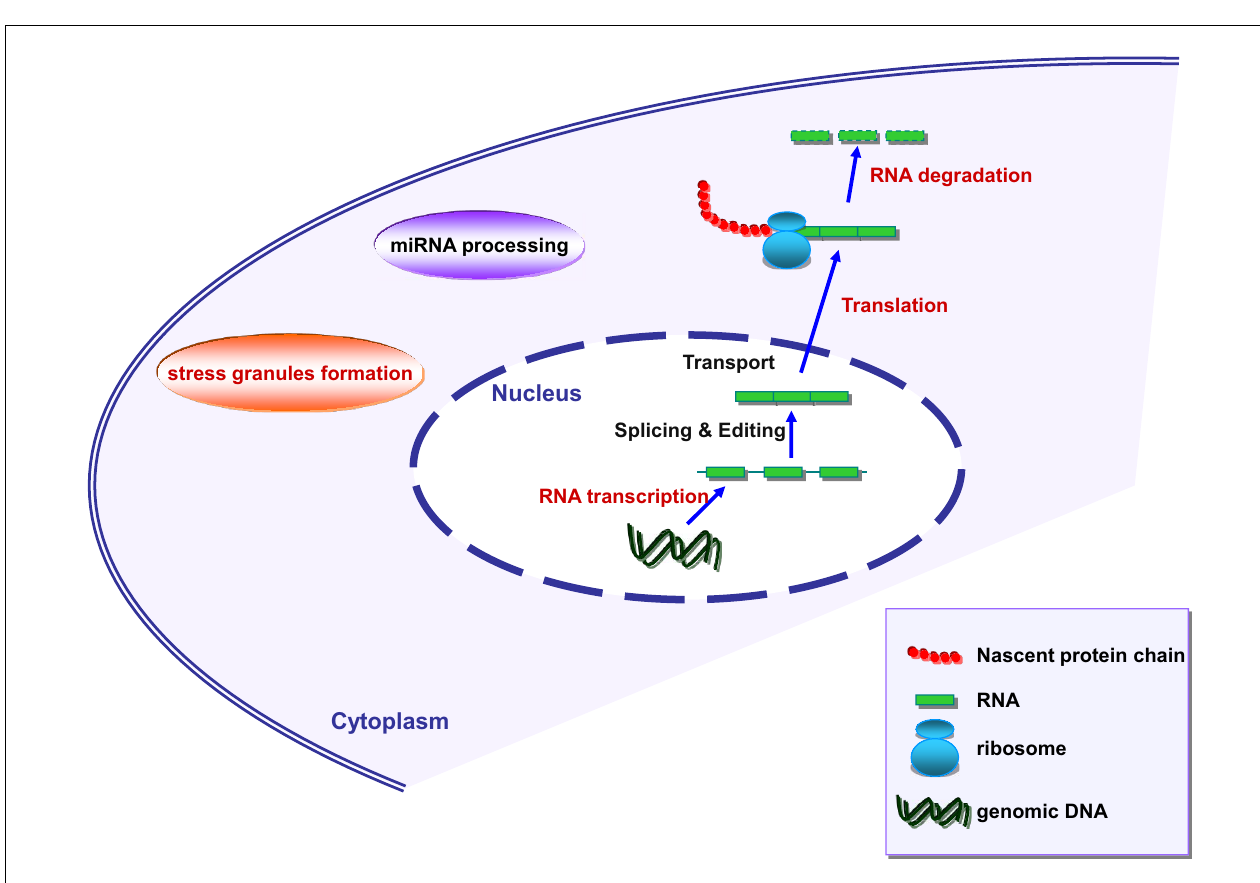
FIGURE 2 | Schematic representation of RNA metabolism in mammalian cells. Marked in red are the processes where angiogenin has been shown to be involved.